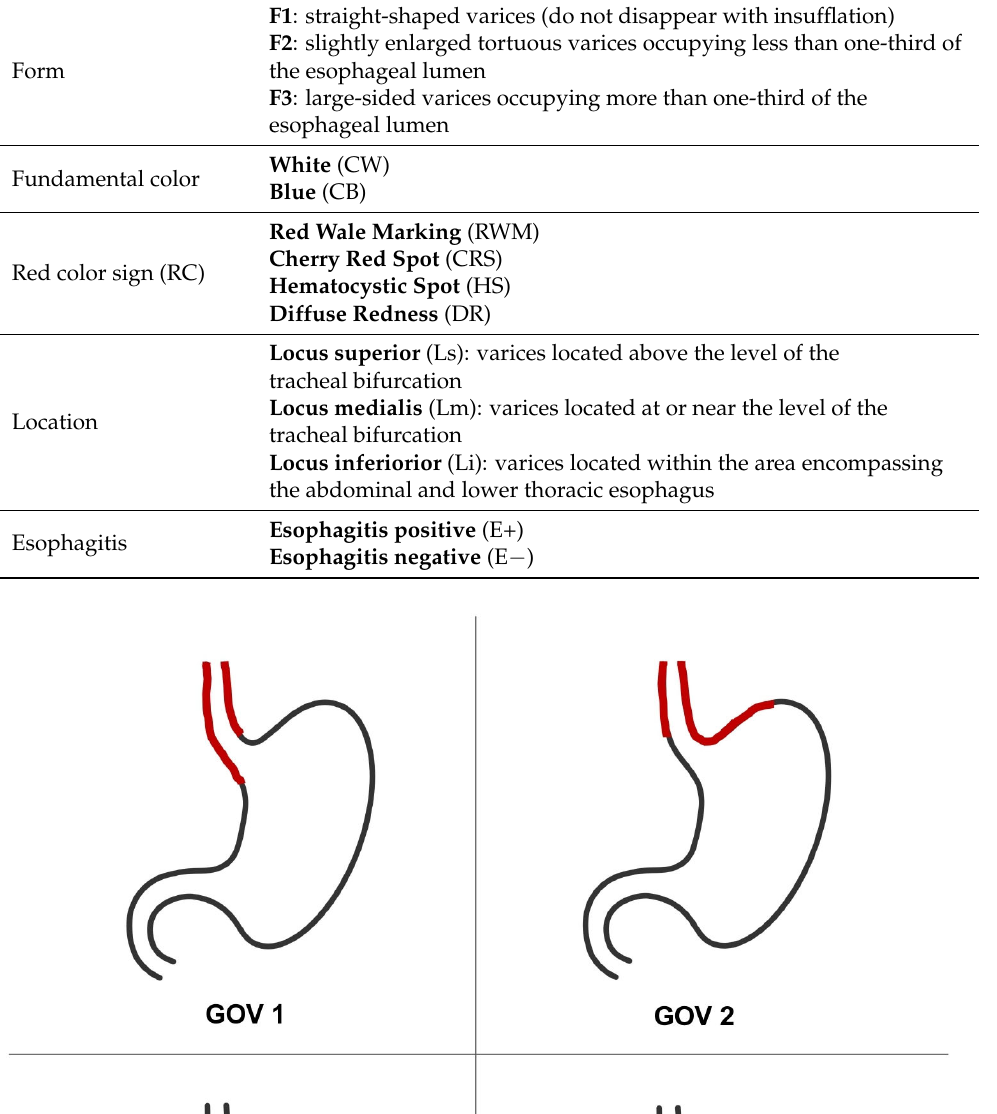
Table 2. Classification of esophageal varices according to the Japanese Research Society for Portal Hypertension (JRSPH) [12].